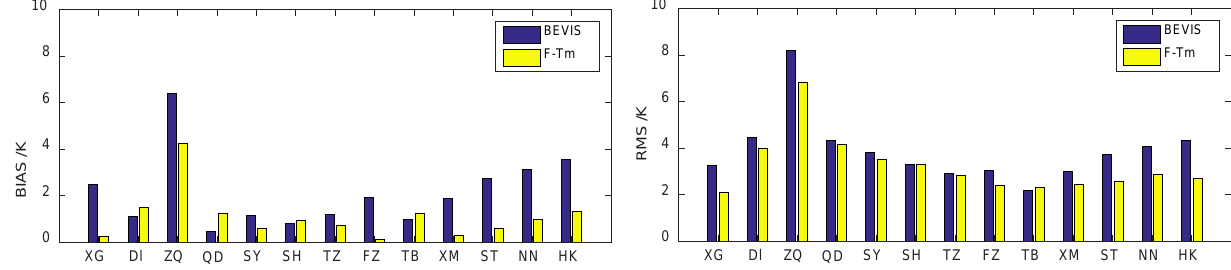
Fig 2. Contrast error of two models of 13 radiosonde stations in 2010-20014 According to the statistics in Figure 2, the F-Tm model has a BIAS value of 0.04k and a RMS increase of 14% in five